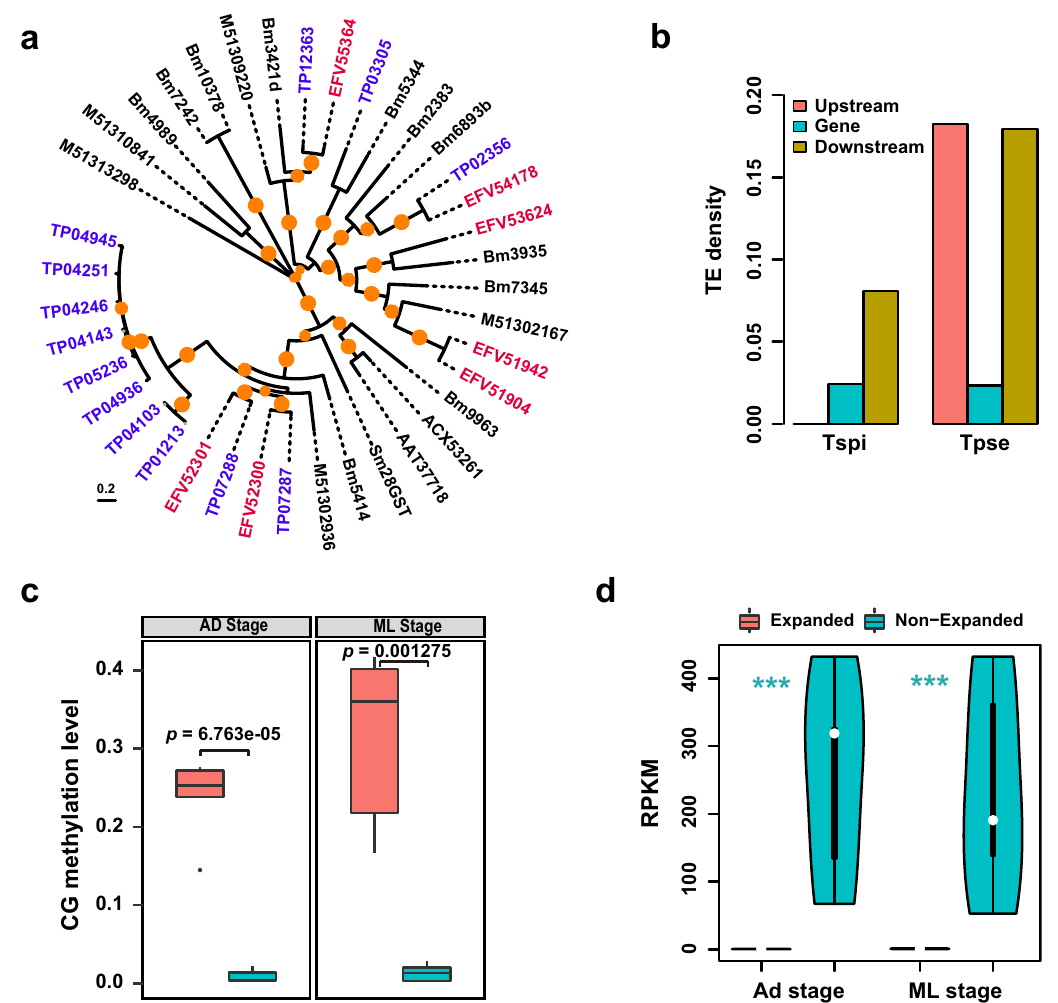
Fig. 4 Differential expansion of glutathione S-transferases family between the two clades of Trichinella . a Phylogenetic relationship of GSTs in T. pseudospiralis , other nematodes (that is T. spiralis , B. malayi and T. sui ) and GSTs with experimentally veri fi ed (that is Sm28GST, ACX53261, AAT37718, EFV54178, and EFV52300). Gene names in blue are from T. pseudospiralis and those in red are from T. spiralis . Nodes with >30% bootstrap support (1000 replicates) are indicated in orange circles. b Comparison of average density of transposon element ( y -axis) around GSTs and their two-kilobase fl anking regions upstream and downstream in T. pseudospiralis and T. spiralis ( x -axis). c Comparison of methylation level between expanded (red) and non-expanded (green) GSTs in Ad (left) and ML (right) stages in T. pseudospiralis . P values were calculated using Mann – Whitney U test. d Comparison of expression level between expanded (red) and non-expanded (green) GSTs in Ad and ML stages in T. pseudospiralis . A Student ’ s t -test was applied to the pairwise comparison. *** indicates P <